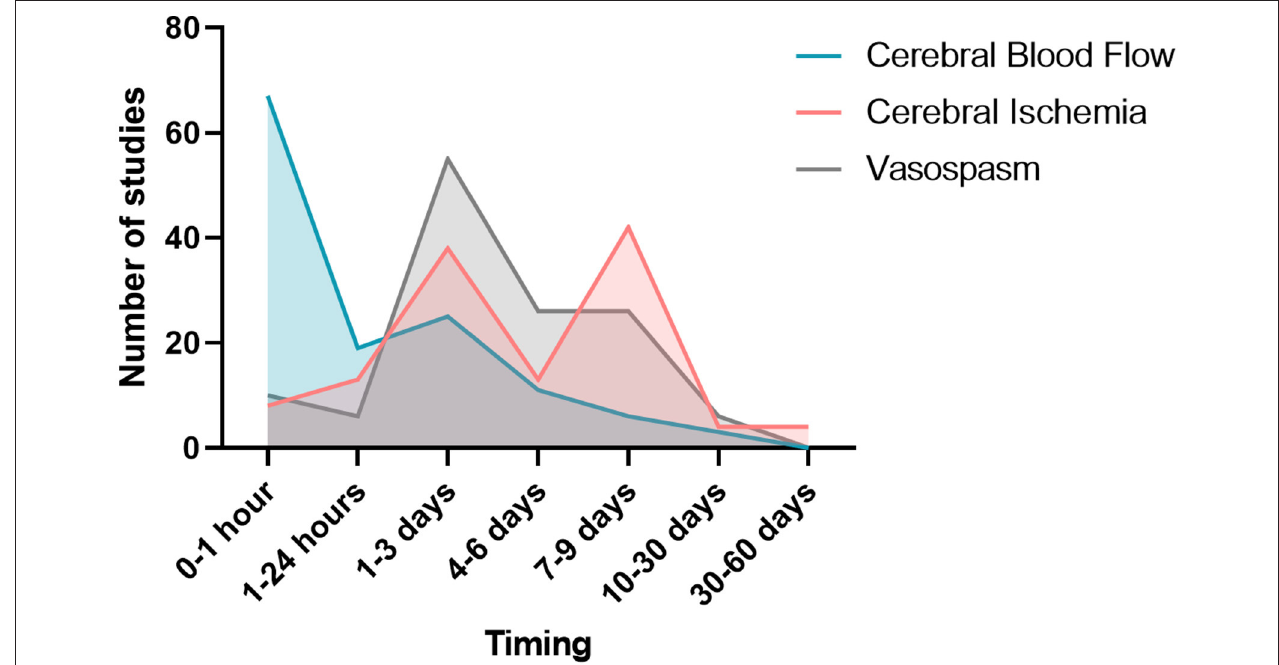
FIGURE 6 | Study window of vasospasm, cerebral blood flow, and cerebral ischemia.